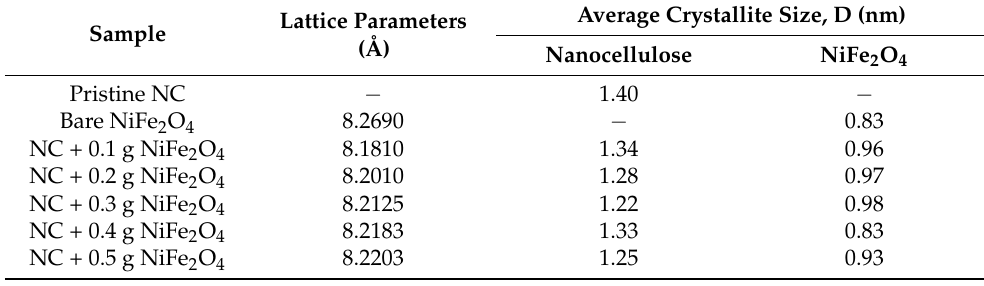
Table 2. Lattice parameters and average crystallite size of nickel ferrite nanocellulose.